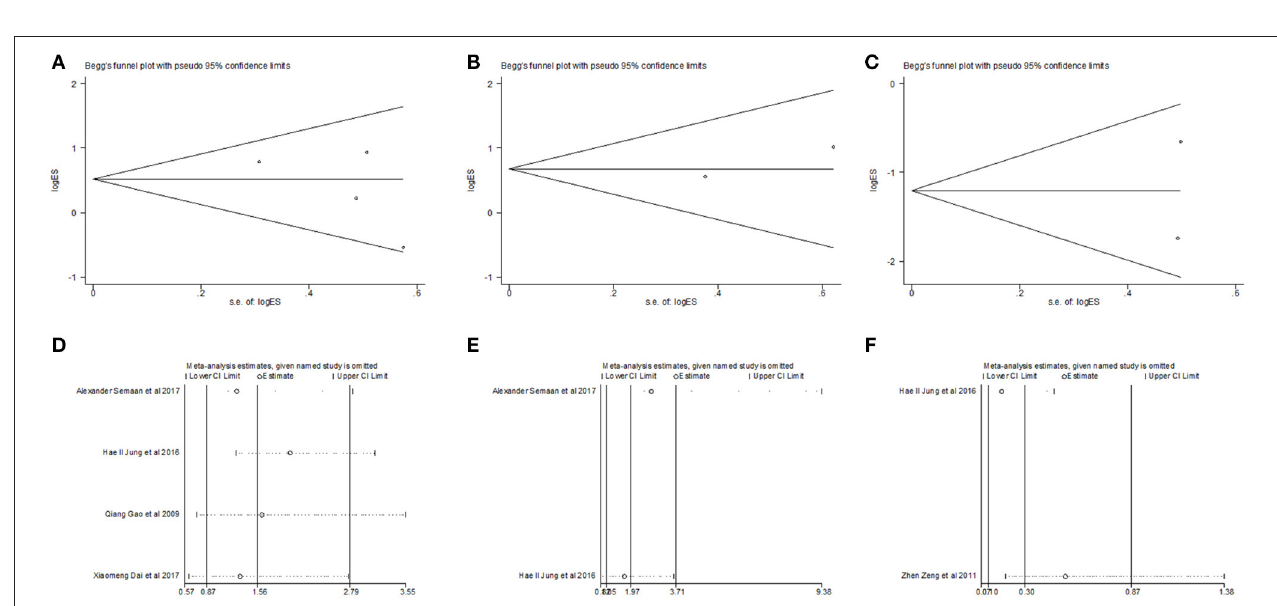
FIGURE 4 | Begg’s funnel plot for publication bias tests in (A) OS, (B) DFS. Sensitivity analysis in (C) OS, (D) DFS.